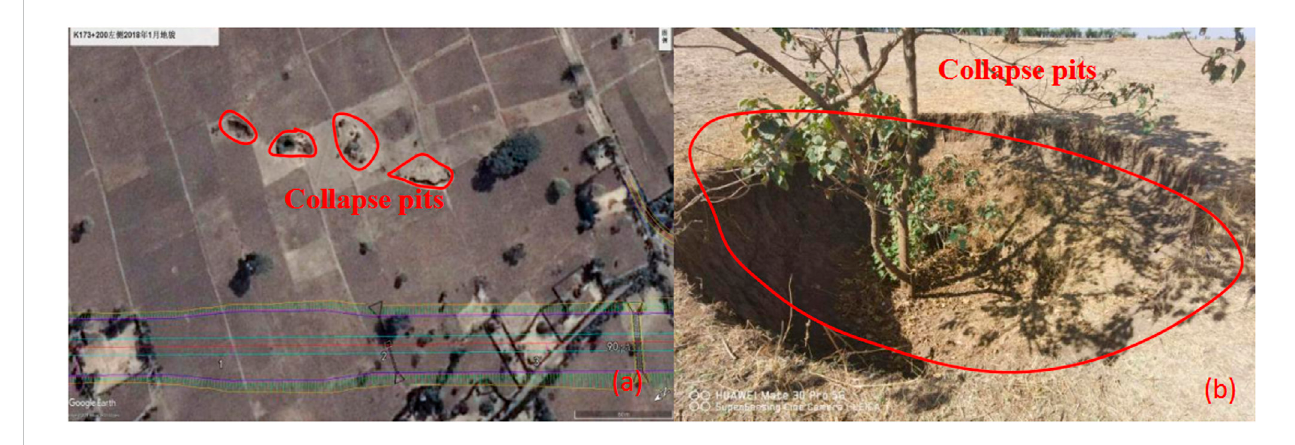
FIGURE 5 String-bead-shaped collapse pits on the right side of K166+300-400.